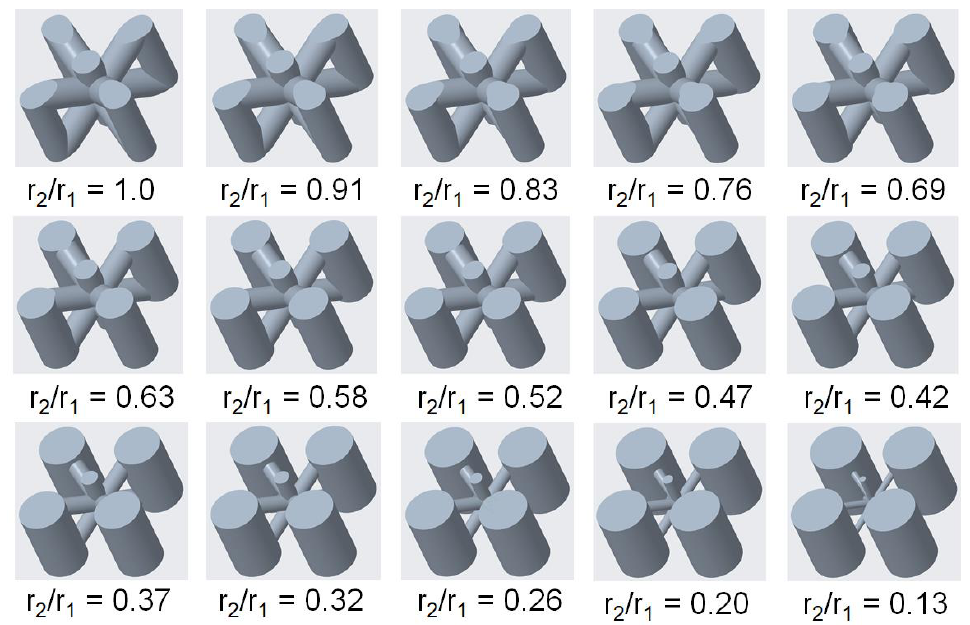
Figure 10. Vertical inclined cellular unit cell with di ff erent ratios of r 1 and r 2 . Table 4. The buckling load for different r 2 /r 1 ratio while the volume and mass remains the same for all samples as indicated in first and second column from the left.